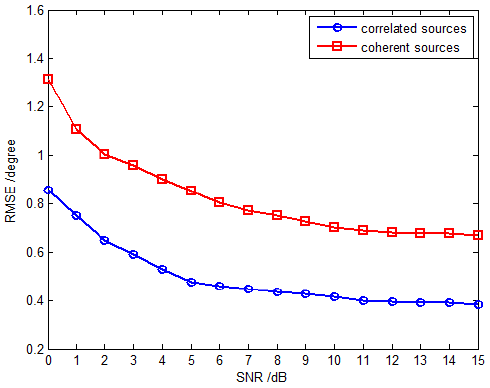
Figure 10. RMSE versus SNR with fixed snapshot number 500.